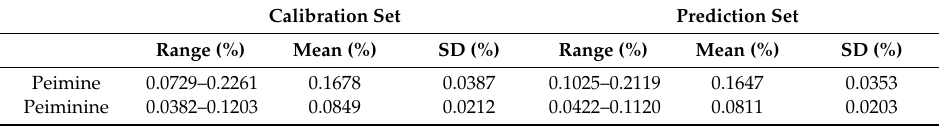
Table 1. Statistical analysis of peimine and peiminine content in the calibration and prediction